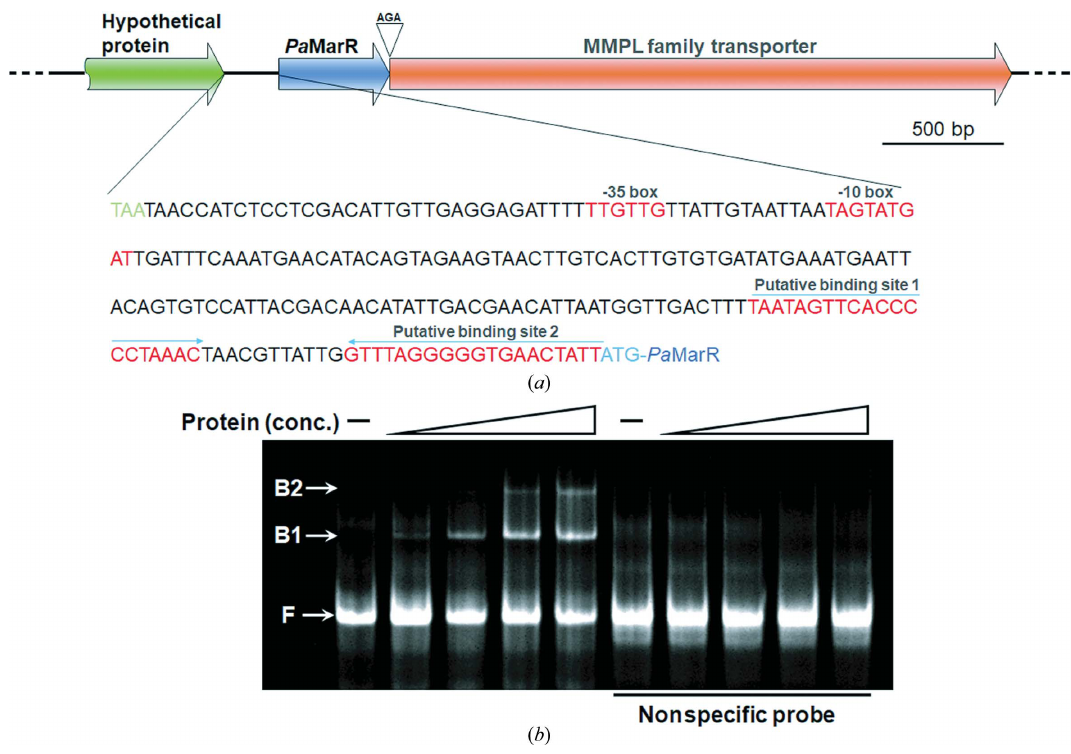
Figure 6 Genetic organization of the pamarR gene and EMSA of the Pa MarR–DNA complex. ( a ) Genetic organization of the Pa MarR and MMPL family transporter-encoding genes in the Paenisporosarcina sp. TG-14 genome and the upstream region sequence of pamarR . The Pa MarR and MMPL family transporter genes are transcribed in the same direction. The putative (cid:3) 10 and (cid:3) 35 boxes of the pamarR promoter located in the intergenic region are marked in red. The putative Pa MarR-binding sites with palindromes predicted by EMBOSS (http://emboss.bioinformatics.nl/cgi-bin/emboss/ palindrome) are shown in red. ( b ) EMSA of Pa MarR and DNA probes containing the putative Pa MarR-binding sites in the intergenic region. The respective Pa MarR protein samples with increasing concentrations (0, 0.3, 0.9, 1.5 and 2.1 m M ) were incubated with oligonucleotide duplexes (0.5 m M ) containing the putative binding sites 1 and 2. The Pa MarR-free (F) and Pa MarR-bound (B1, either putative binding site 1 or 2; B2, both putative binding sites 1 and 2) probes are indicated by